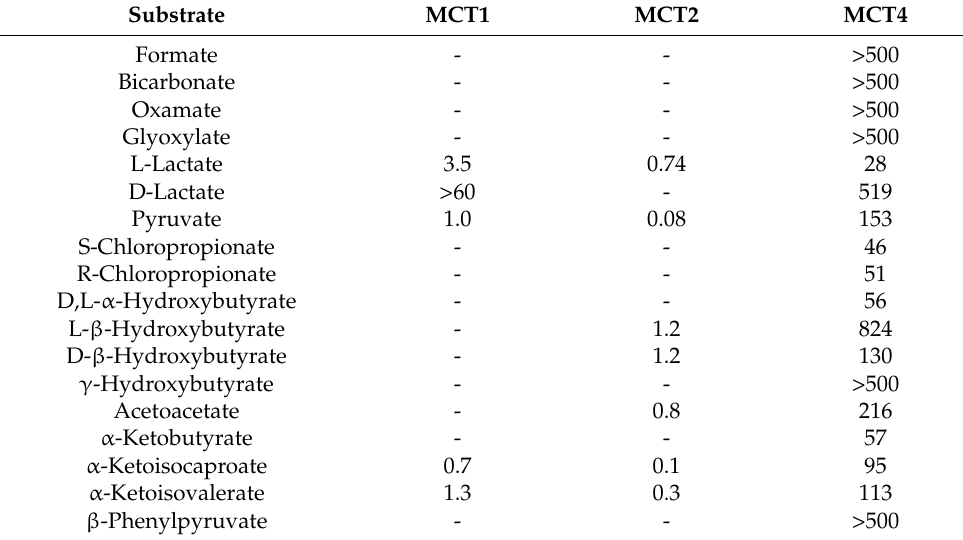
Figure 2. Cryo-electron microscopy (EM) structure of human MCT1/basigin complex. MCT1 with 12 hydrophobic helical TMDs ( beige ) forms a functional complex with its chaperone basigin ( blue ). Data were obtained from UniProt (P53985). Table 1. K m values for MCTs 1, 2 and 4. K m values in mM determined in Xenopus oocytes. Modified from Halestrap,